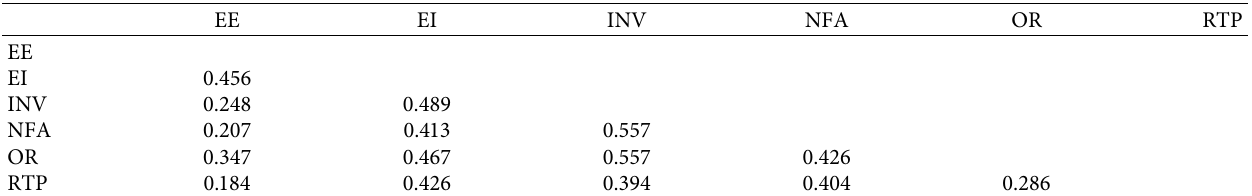
Table 5: Heterotrait monotrait ratio